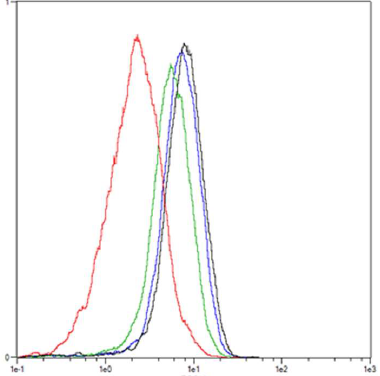
Figure A2. Representative flow cytometric analysis of ROS formation in SISO cells. Cells were treated with solvent in the dark (red) or mTHPC alone (blue), 1-OHP alone (green) or a combination of THPC and 1-OHP (black) prior to illumination with 1.8 J/cm 2 and stained with H 2 DCF-DA 48 h post illumination. For each sample, 10,000 events were counted and gated for the single cell population (not shown). Fluorescent DCF is formed within the cells after contact with ROS and the detected fluorescence intensity is increased with higher amounts of ROS. The B1 channel ( λ Ex/Em = 488 nm/525– 550 nm) of a MACS Quant flow cytometer was used for the detection of DCF and data were analysed with the MACS Quantify Software.